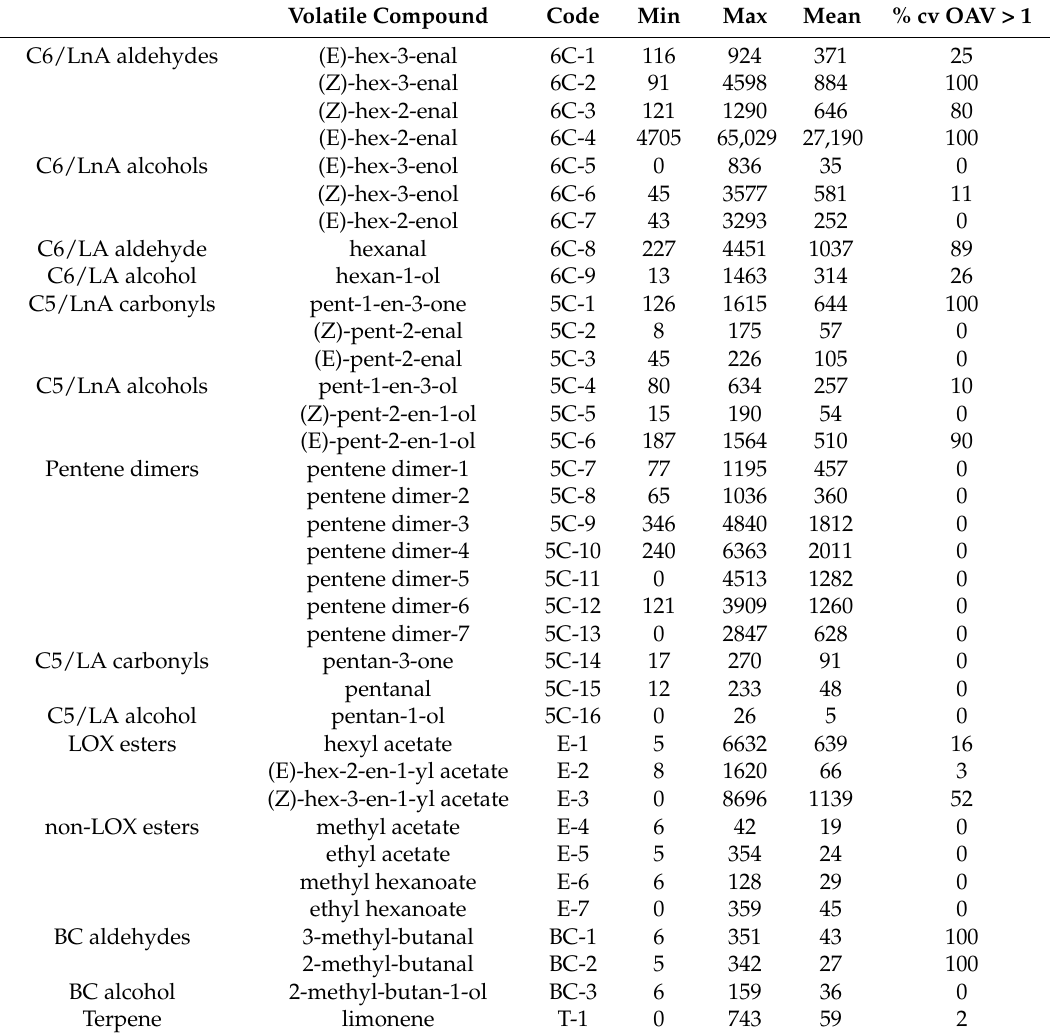
Table 2. Content of the volatile compounds (ng/g oil) in the oils from the WOGC cultivar subset and percentaje of cultivars with odor activity values (OAV) higher than 1 for each volatile